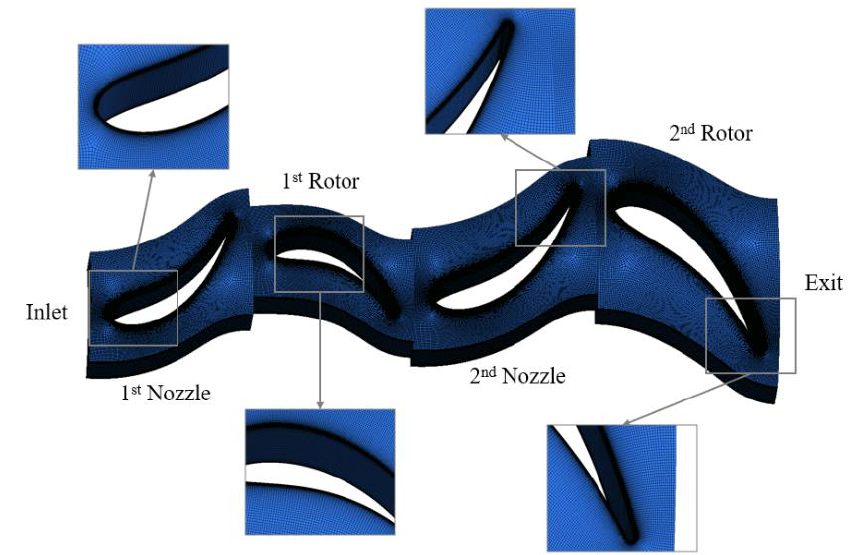
Figure 8. One-passage geometry and mesh of the two-stage radial outflow turbine.